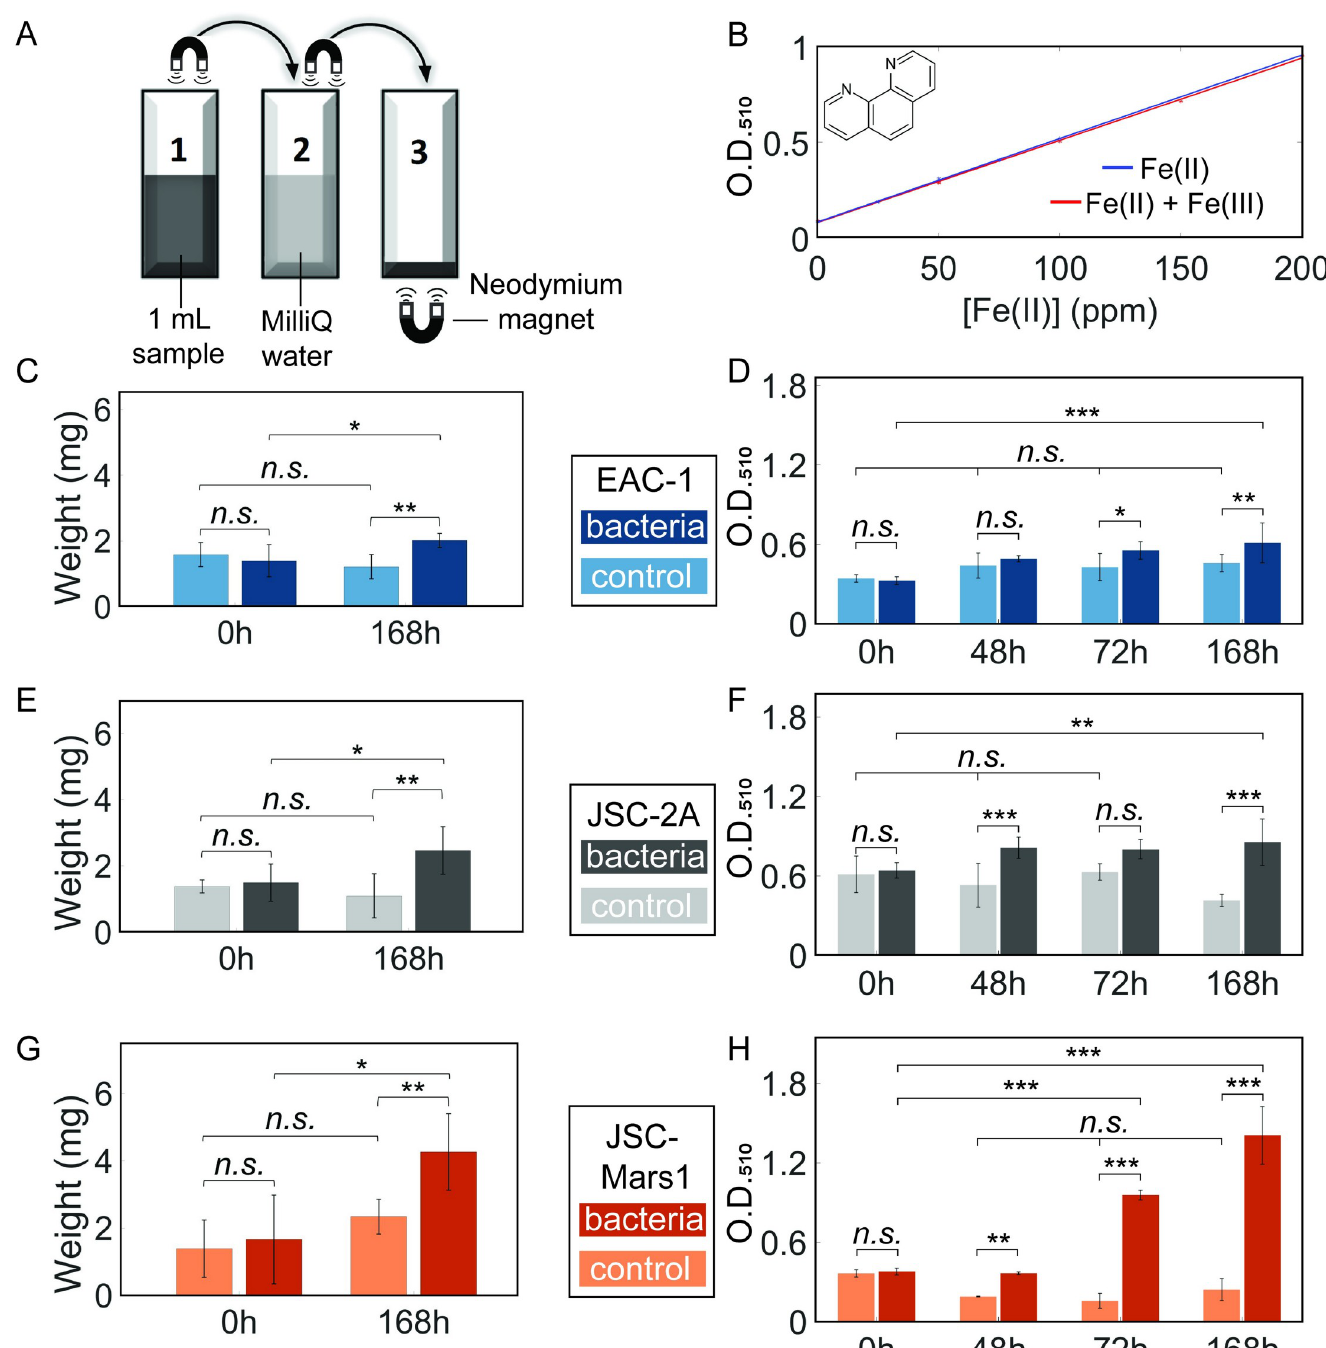
Fig 3. Aerobic extraction of magnetic material and determination of aqueous ferrous iron concentration from EAC-1 (blue), JSC-2A (grey), and JSC-Mars1 (orange) regolith simulants. The darker color in each plot represents the bacterial sample, the lighter one the non-bacterial control. (A) The set-up for small-scale magnetic extraction. In short, 1 mL sample (1) was pipetted into a cuvette, then the magnetic fraction was extracted via a magnet, washed in a MilliQ water (2), and finally dried in a previously weighed cuvette (3). The weight difference of the cuvette before and after this treatment represents the extracted magnetic material. (B) Absorbance of Fe(II) iron standards bound to 1,10-Phenanthroline in the absence and presence of Fe(III). O.D. 510 was measured for a range of 0–200 ppm Fe(II) (aq) with or without a constant concentration of 100 ppm Fe(III) (aq) . (C, E, G) The weight of magnetically extracted material from samples containing 10g/L EAC-1 (C), JSC-2A (E), or JSC-Mars1 (G) solution with and without S . oneidensis after 0h and 168h. An increase of the magnetically extractable material was measured for all of the bacterially treated samples (n = 6). (D, F, H) Absorbance of the colorimetric iron determination of 10 g/L EAC-1 (D), JSC-2A (F), and JSC-Mars1 (H) treated with